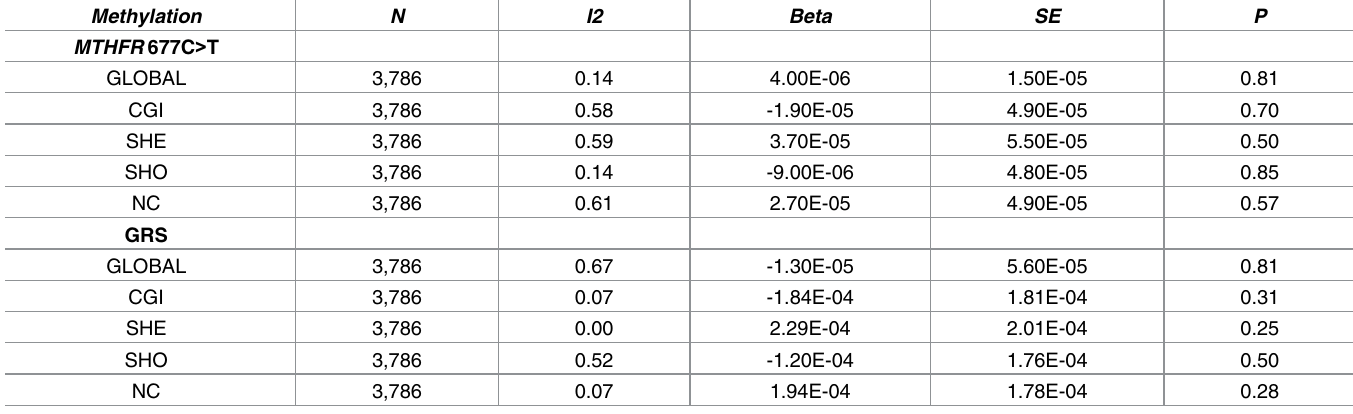
Table 3. Association of MTHFR 677C > Tand Genetic Risk Score on mean global methylation